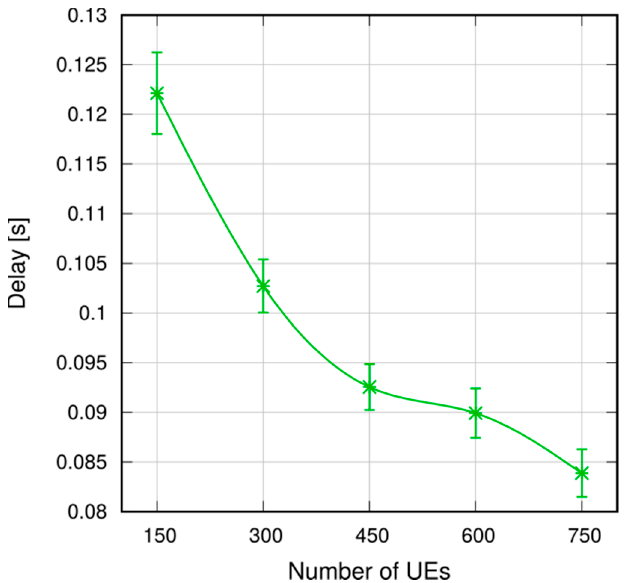
Figure 22. 95th percentile of delay, dense scenarios.